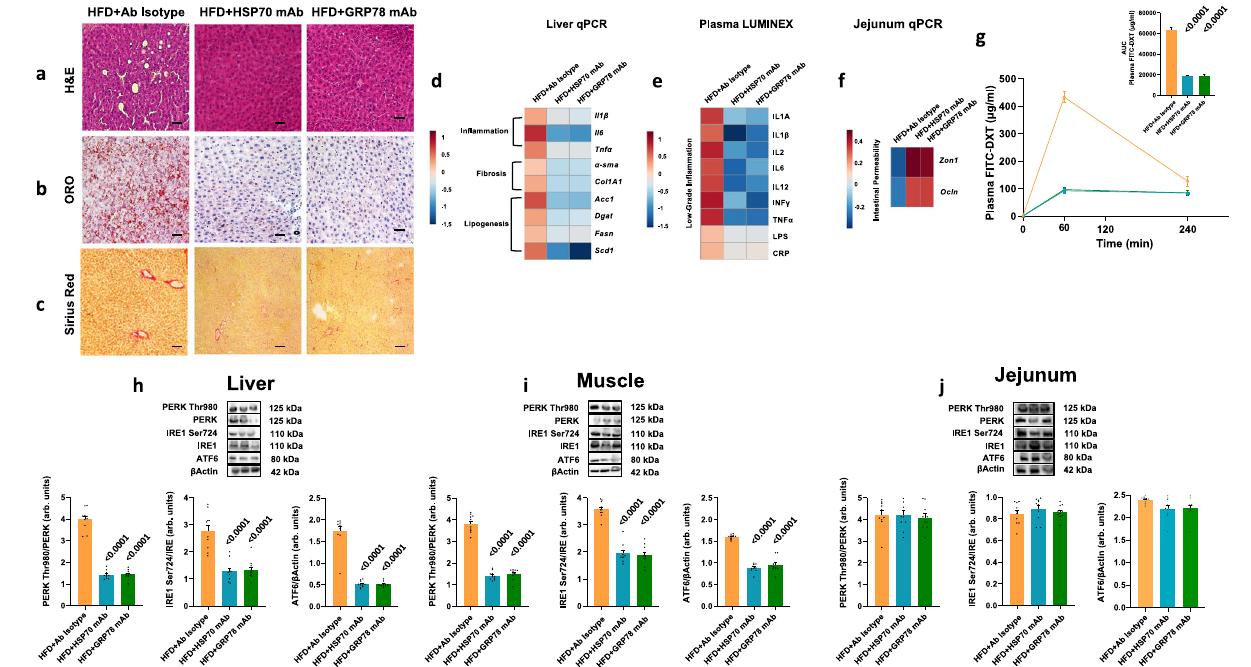
Fig. 5 | Effects of native HSP70/GRP78 inhibition with mAbs on NASH hall- marks. a – c Representative Hematoxylin and Eosin (H&E) ( a ), Oil Red O (ORO) ( b ), andPicroSiriusRed(c)stainingofliversectionsfromratsfedHFDandinfusedwith monoclonal antibodies against HSP70 or GRP78 or antibody isotype. d Gene expression of liver in fl ammation and fi brosis markers as well as key enzymes involved inhepaticdenovo lipogenesis. e Plasmalow-gradein fl ammation markers assessed by Luminex. f Gene expression of key genes involved in intestinal per- meability. g Time course and AUC of in vivo intestinal permeability assessed by